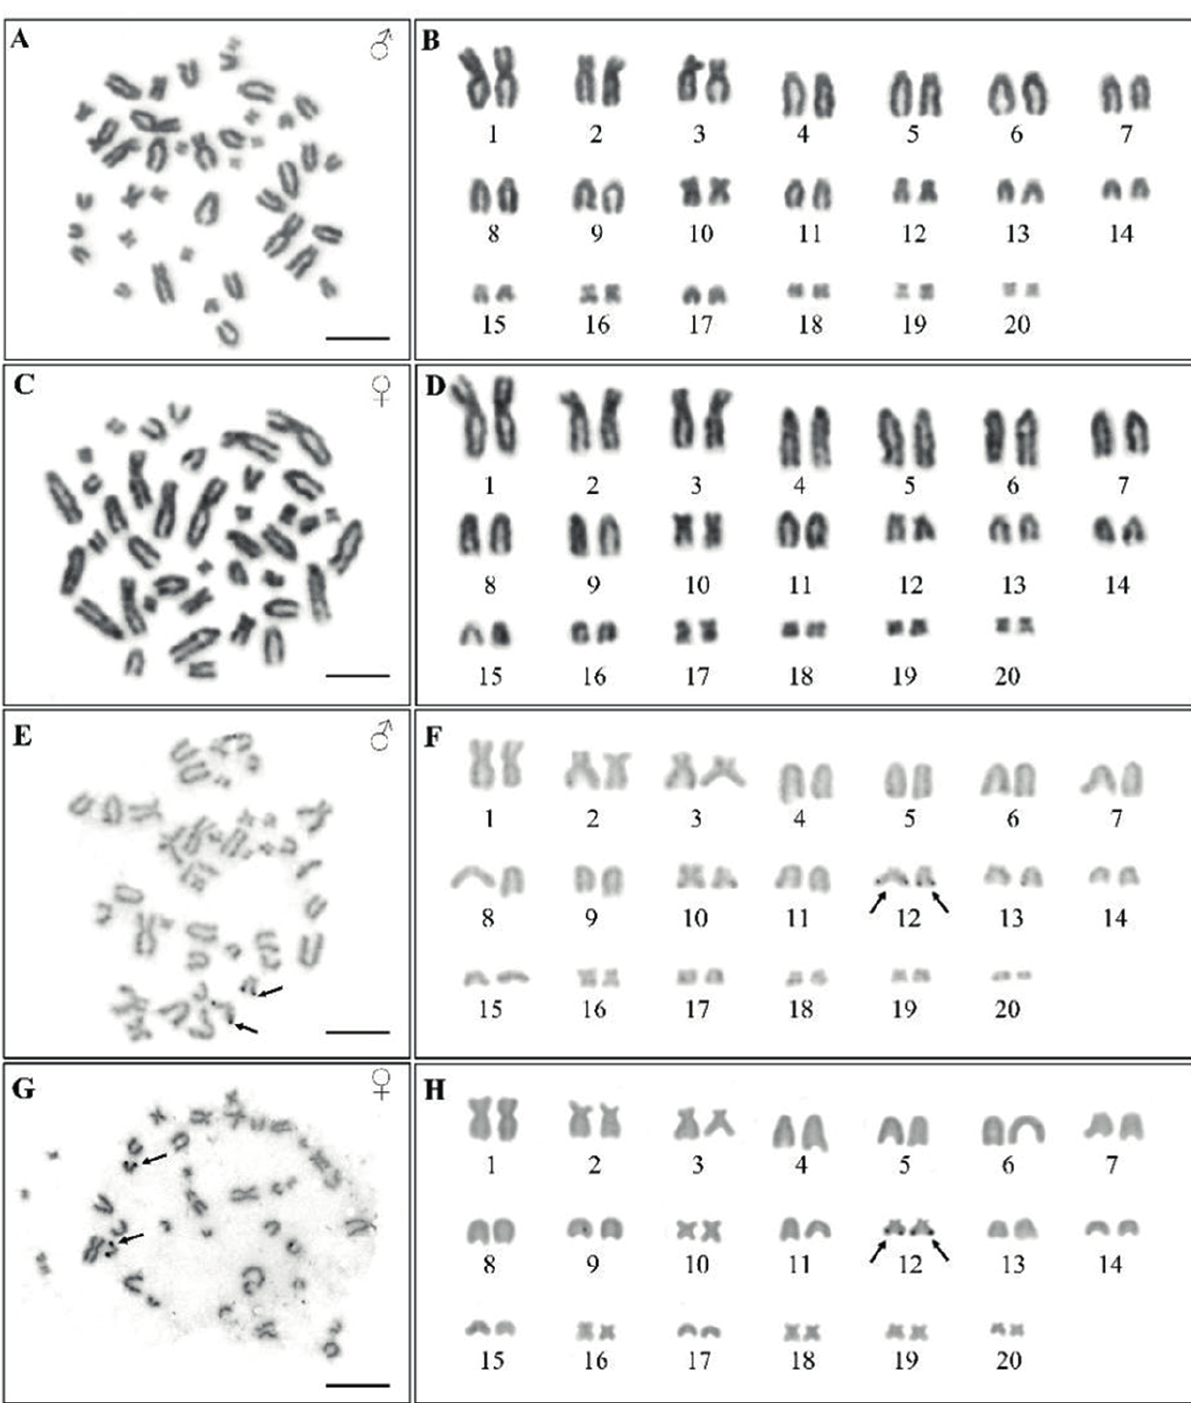
Figure 2. Metaphase chromosome plates and karyotypes of male and female Cyrtodactylus inthanon, 2 n =40 by conventional staining (A-D) and Ag-NOR banding technique (E-H). Scale bars indicate 5 micrometers. The arrows indicate nucleolar organizer